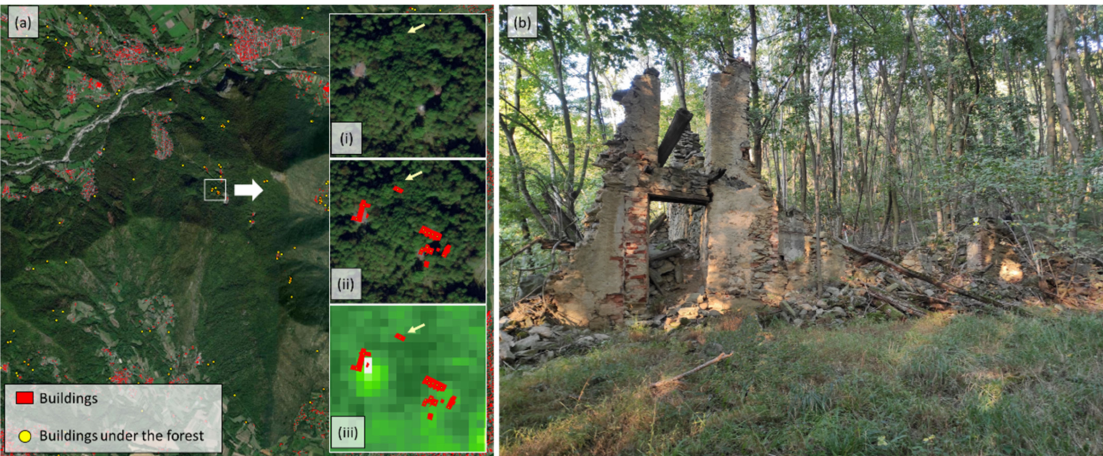
Figure 3. ( a ) Location of the heritage element chosen for testing the different geomatic sensors (37,5016.508 East; 4,986,232.369 North—WGS 1984, UTM Zone 32 N). On the right and from top to bottom: (i) The first white box shows the orthophotography of the chosen site. As can be see it is completely covered by vegetation. (ii) In the second frame it is possible to see the overlapping layer of buildings, with the yellow dots of the survey done (where it indicates that the building is under a wooded area). (iii) The third frame shows the High-Resolution Layers-Forest layer, where the layer of the buildings and the layer of the dots under the forest have been overlaid.; ( b ) Image of the heritage